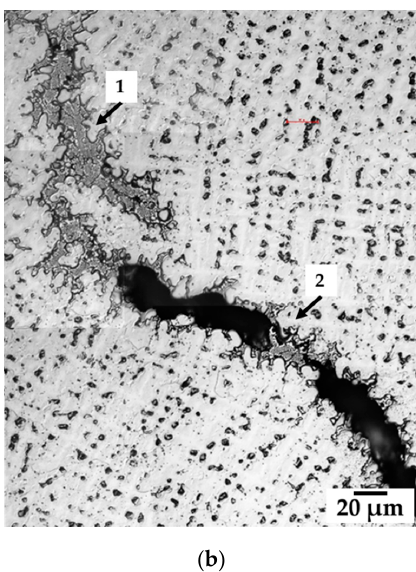
Figure 4. SEM micrograph showing the unetched microstructure of the fusion zone of the welded sample; ( a ) showing an “open” crack and ( b ) showing completely backfilled crack (arrow 1) and partially backfilled crack (arrow 2).